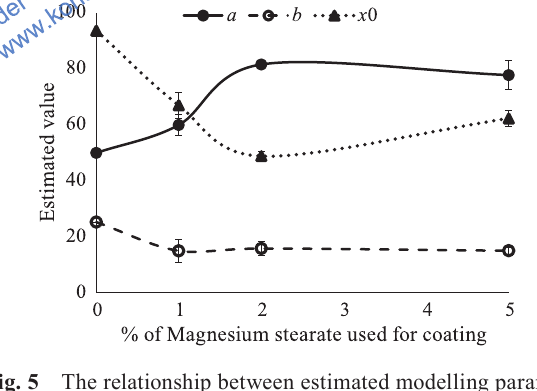
Fig. 6 Surface energy distributions of uncoated and 1, 2 and 5% (w/w) magnesium stearate (MgSt) coated salbu - tamol sulphate (SS) determined by inverse gas chroma - tography using finite dilution